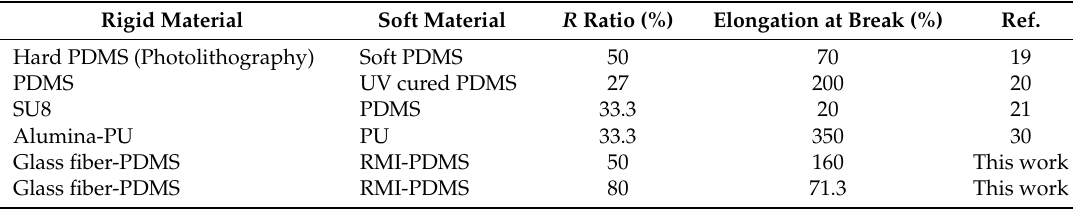
Table 1. Comparison of di ff erent stretchable iPCB for stretchable electronic devices. RMI: reverse micelle induced, PDMS: polydimethylsiloxane.